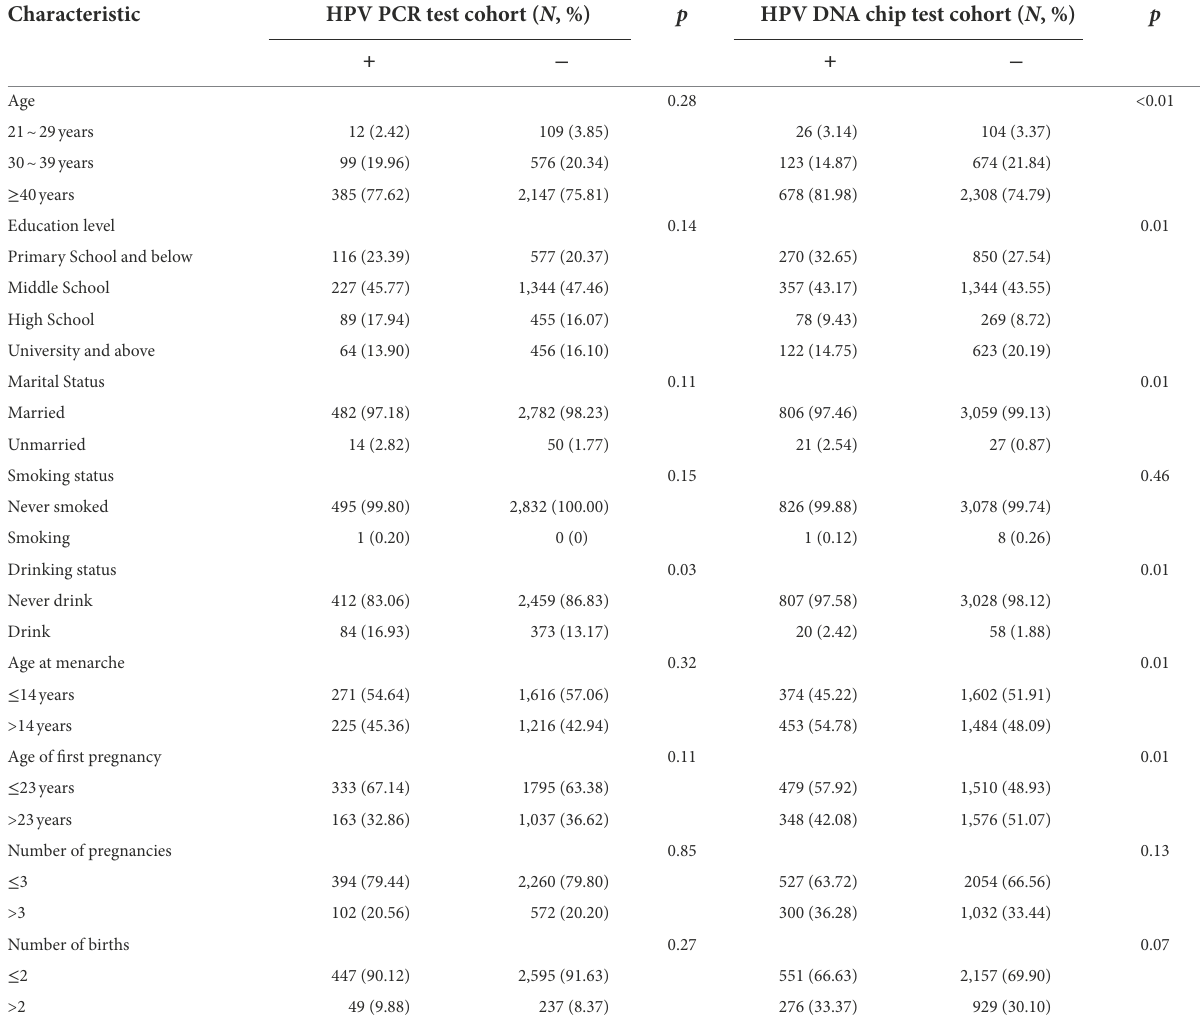
TABLE 1 Population characteristics of different HPV testing cohorts at